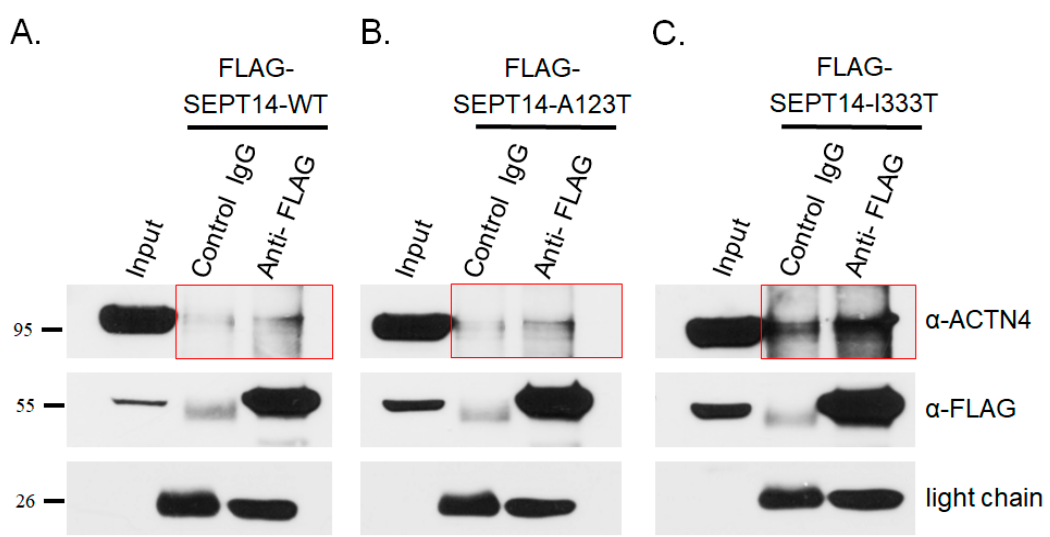
Figure 5. Mutated SEPT14 does not affect the formation of SEPT14/ACTN4 complexes. Co-IP analysis of the binding between SEPT14 and ACTN4. SEPT14-WT, SEPT14-A123T, and SEPT14-I333T are shown in Figures ( A , B , and C ), respectively. Lysates of HeLa cells transfected with pFLAG-SEPT14 (WT or mutant) were subjected to IP with nonspecific control IgG (Control IgG) or a FLAG antibody (Anti-FLAG) and then immunoblotted with a FLAG ( α -FLAG) or ACTN4 ( α -ACTN4) antibody. Input protein (5%) was used as a control for immunoblotting of the transfected cell lysates (Input). The light chain was used as a loading control.